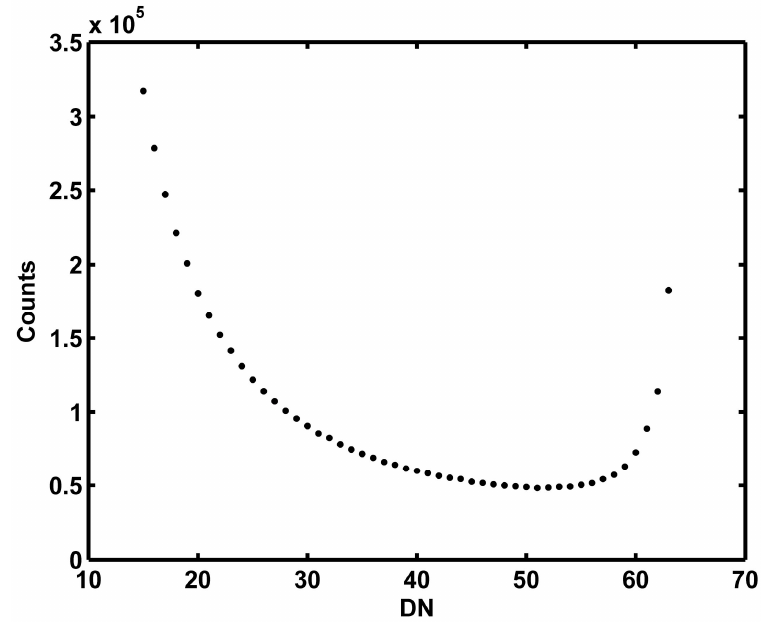
Figure 4. Distribution rule of the DNs of the 2006 SNL image F162006 (dots for DN < 15 have been omitted in the figure to better show the shape of the curve).